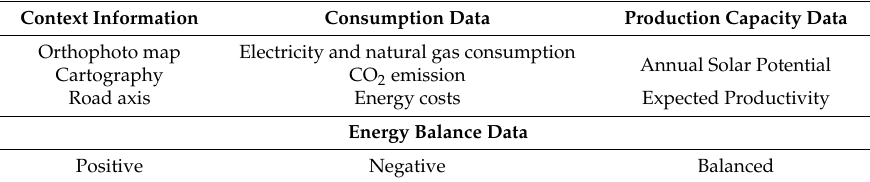
Table 1. Main theme of the Geographic Information Data Model.